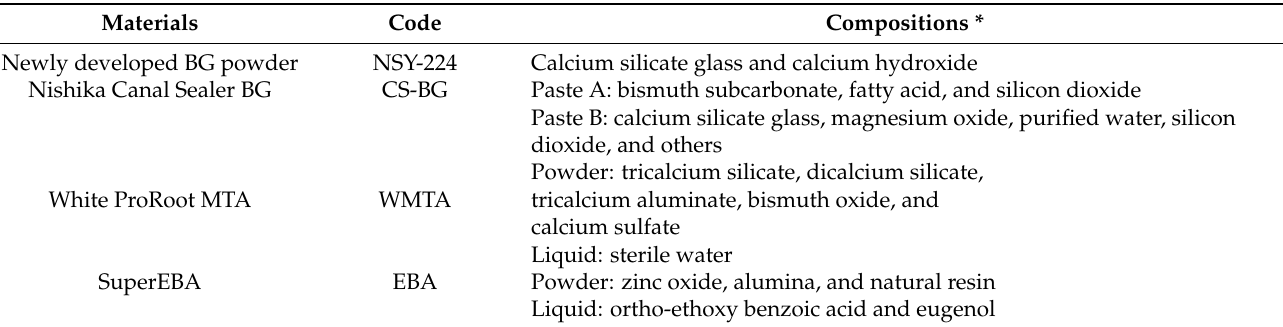
Table 1. Components of NSY-224, CS-BG, WMTA, and